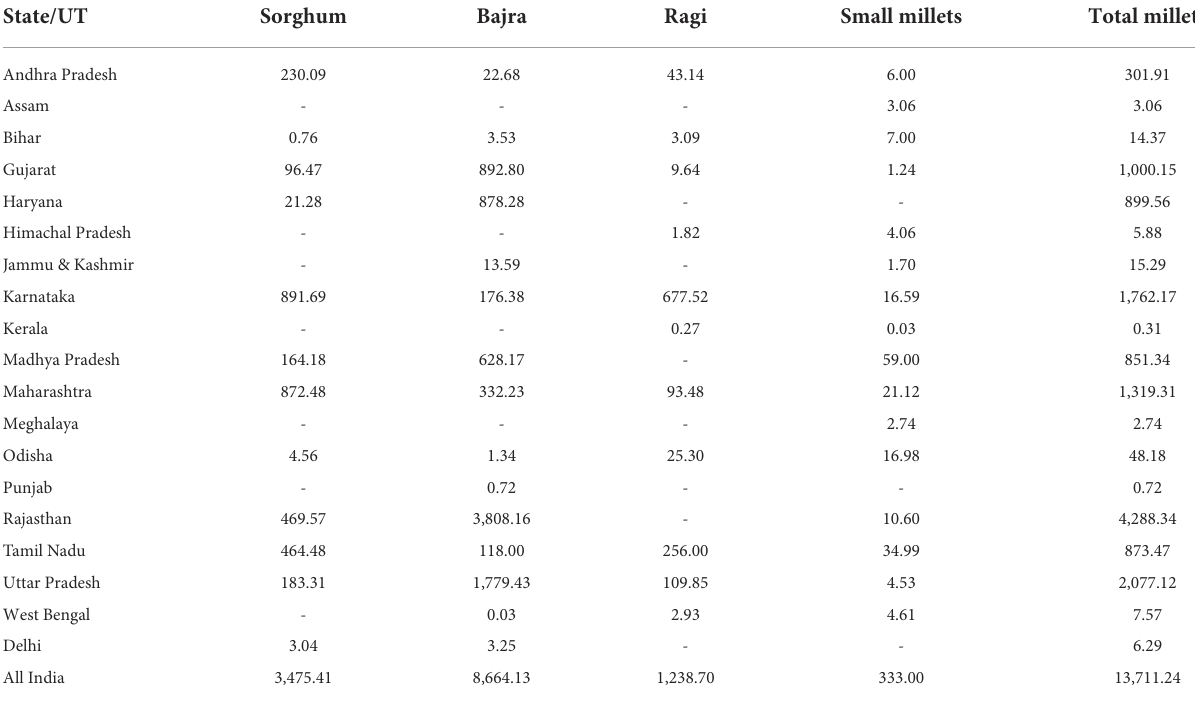
TABLE 2 State wise production of millets during 2018–19 (production in tons). State/UT Sorghum Bajra Ragi Small